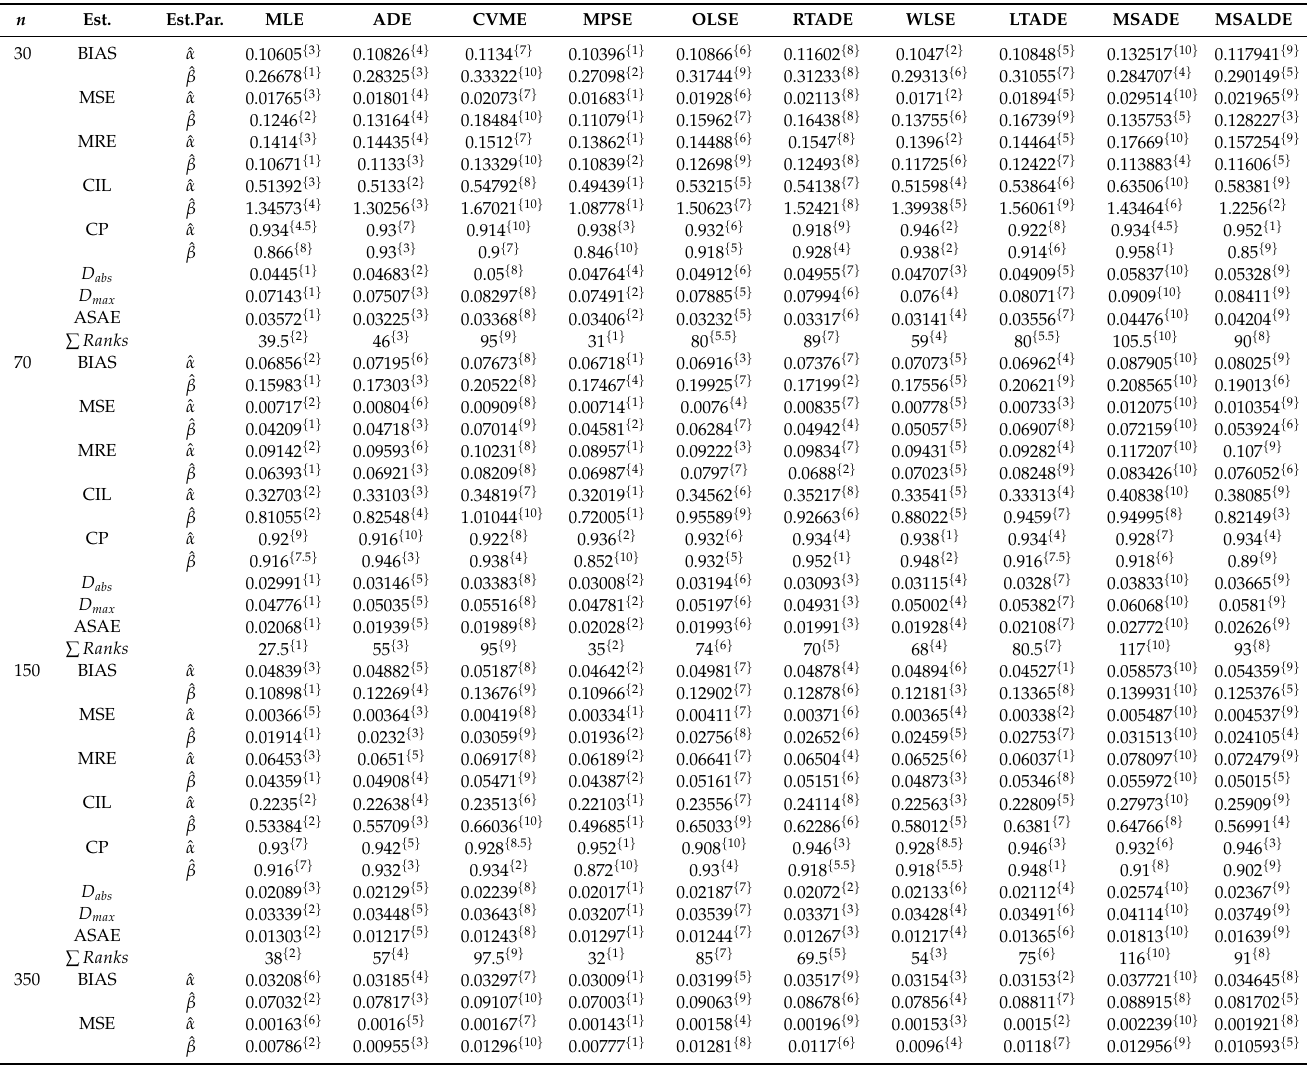
Table 2. Numerical values of PHD simulation for ( α = 0.75, β = 2.5 )